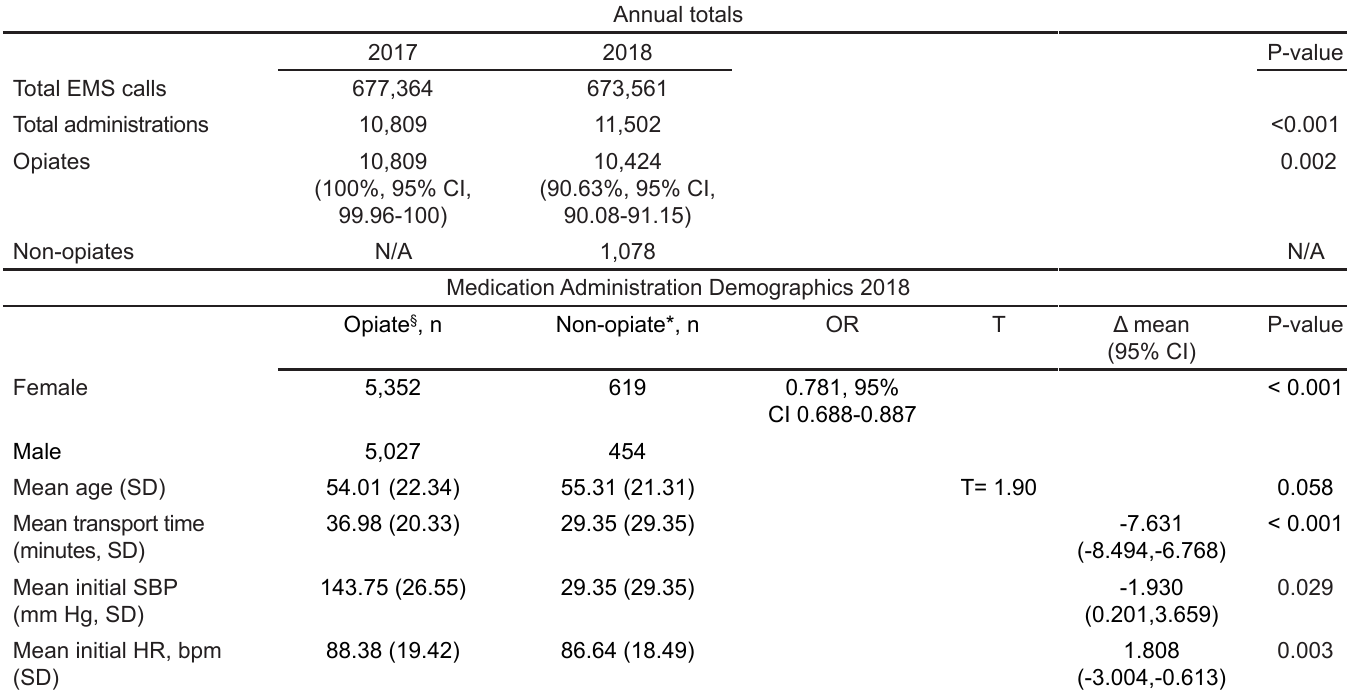
Table 2. Medication administration by